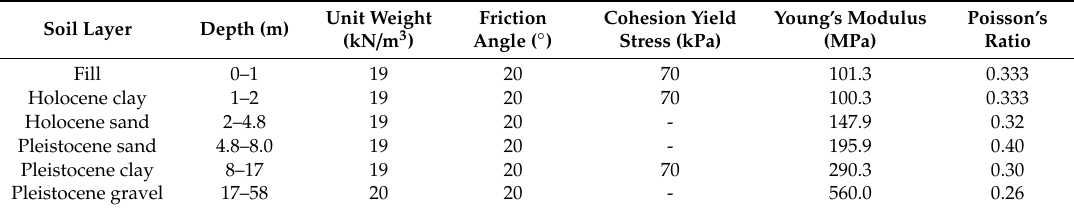
Figure 2. Pressure-dependent soil material model